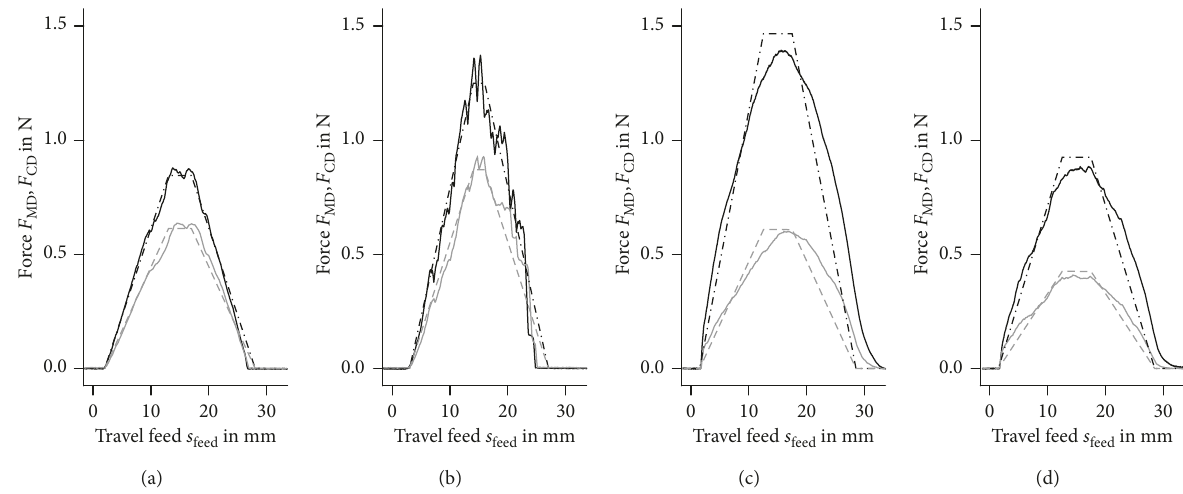
Figure 8: Plot the force in respect to the feed during a cut. The angle λ � 45 ° and the wire has a diameter of d � 1mm/s. The F v MD is shown in black and the F CD in grey. The dash-dot lines represent the fitted force curves and the continuous lines speed result from the corrected measurements. (a) Edam Cheese. (b) Leberk¨ase. (c) Bubble gum 1. (d) Bubble gum 2.